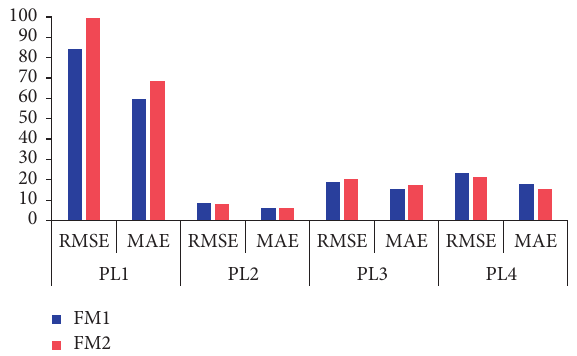
Figure 7: Comparison between FM1 and